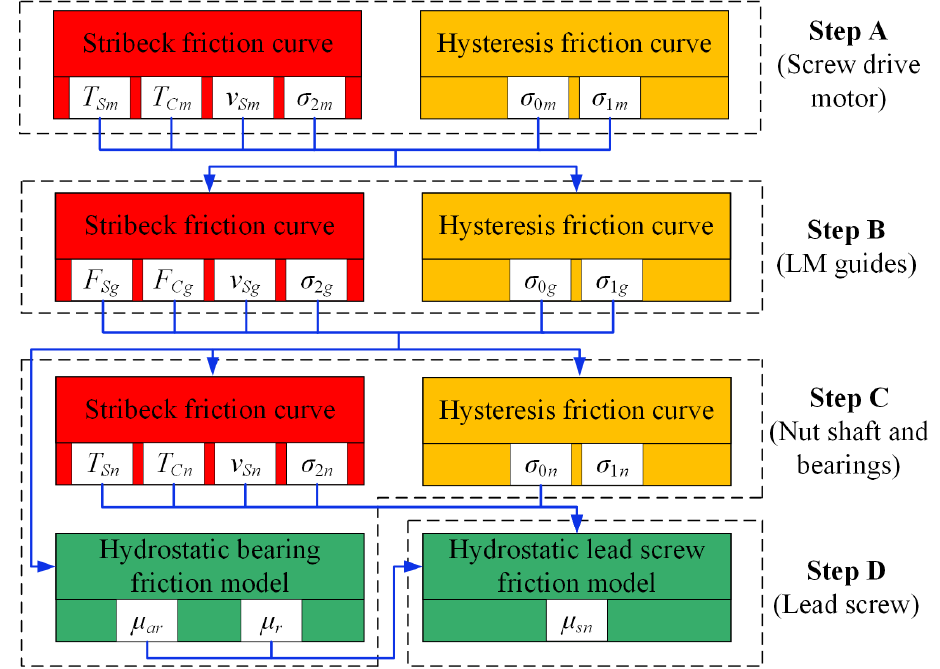
Figure 7. Flowchart of the ACRFIM.